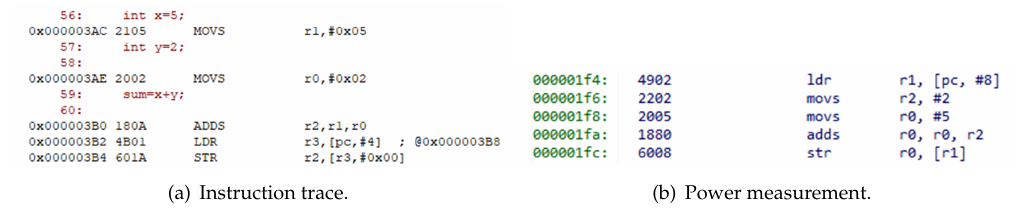
Figure 4. Executed assembly codes in both